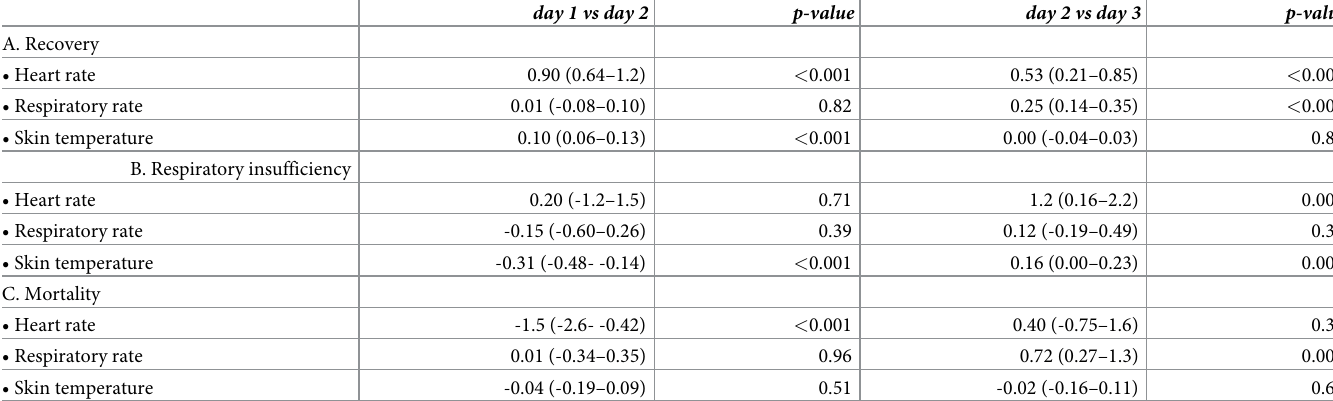
Table 3. Differences in cosinor mixed effect model amplitudes (difference, 99%CI) between days for the A. recovery cohort, B. respiratory insufficiency cohort, and C. mortality